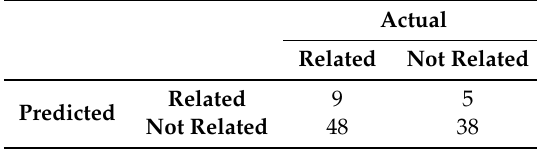
Table 11. Confusion matrix for comparison, only using IR and matching one word “robot”.